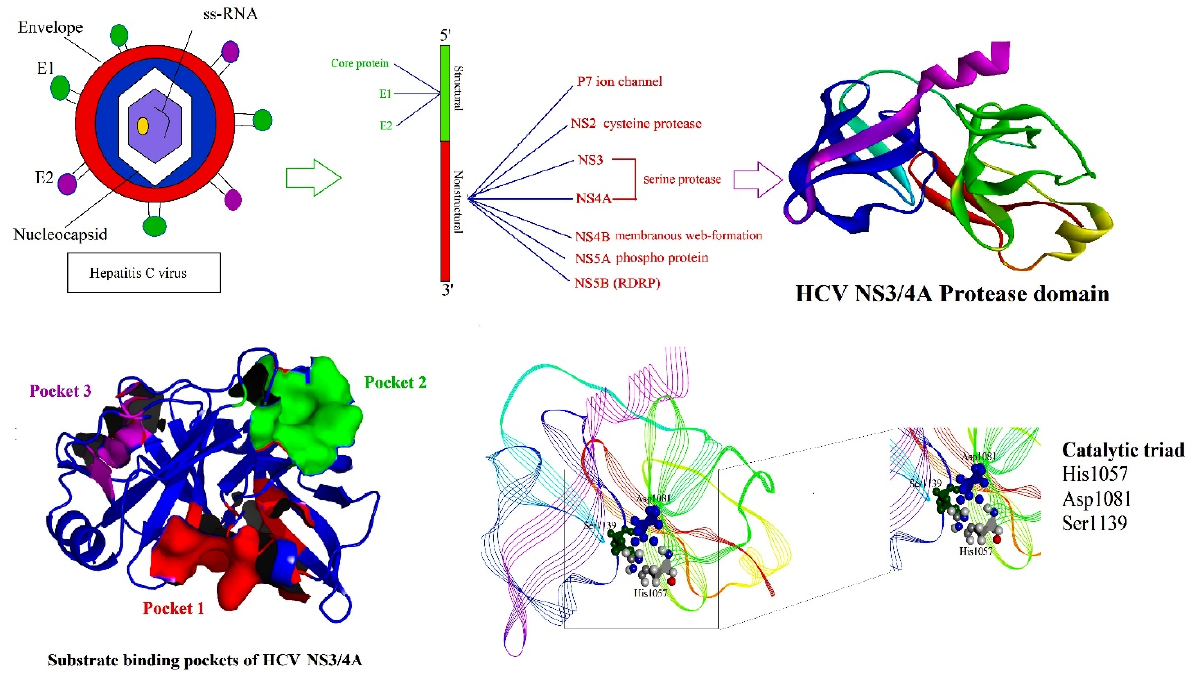
Figure 1. HCV, NS3 X-ray crystallographic structure, substrate binding pockets, and its catalytic triad residues.